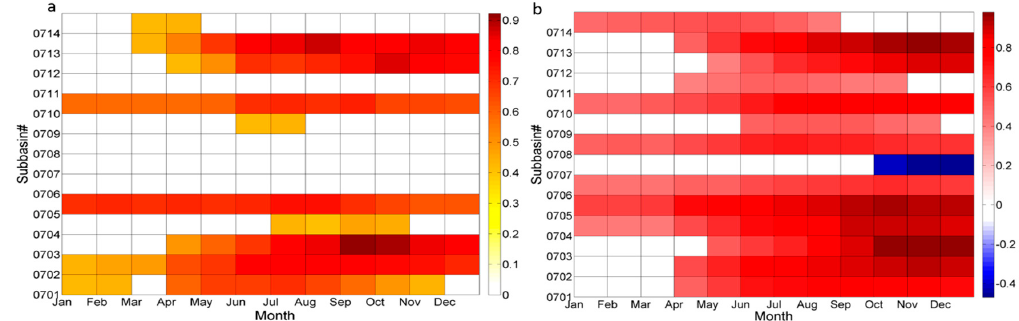
Figure 5. The correlation coefficients (r) between annual freshwater provisioning ( FWP ) and SPI 12 series ( a ); as well as SSI 12 series ( b ) for each month in 14 HUC4